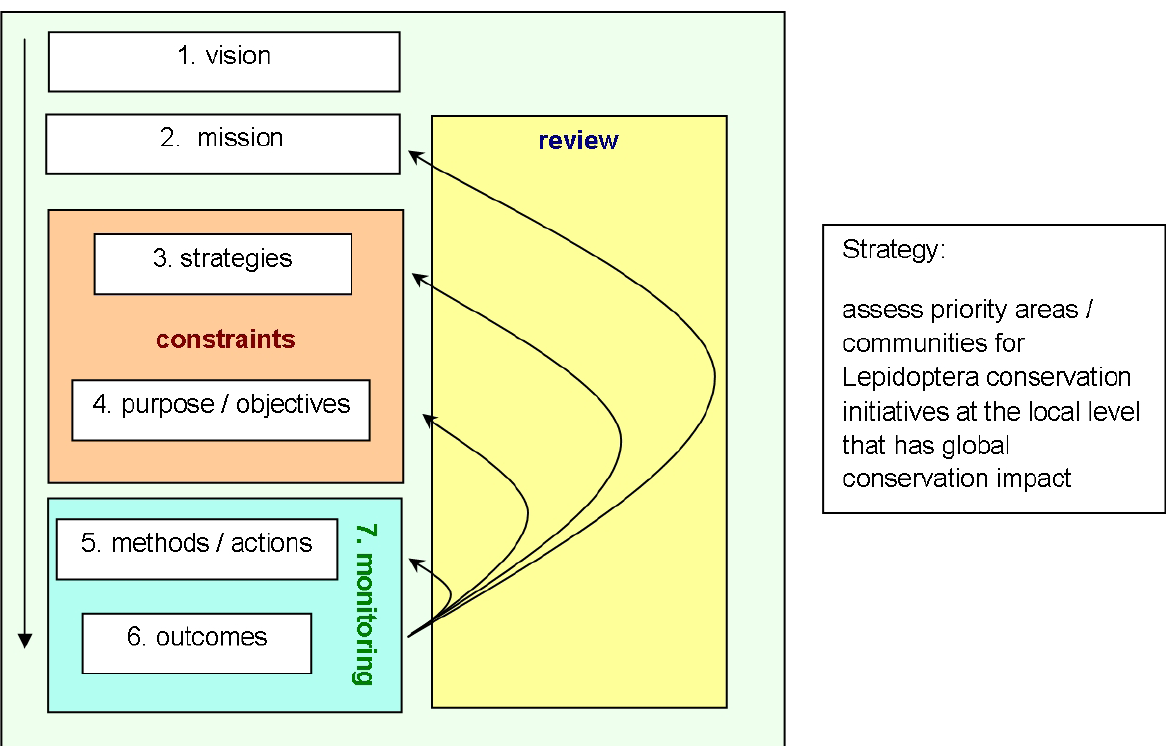
Figure 1. Conservation framework model (based upon COP6 of CBD, 2002)